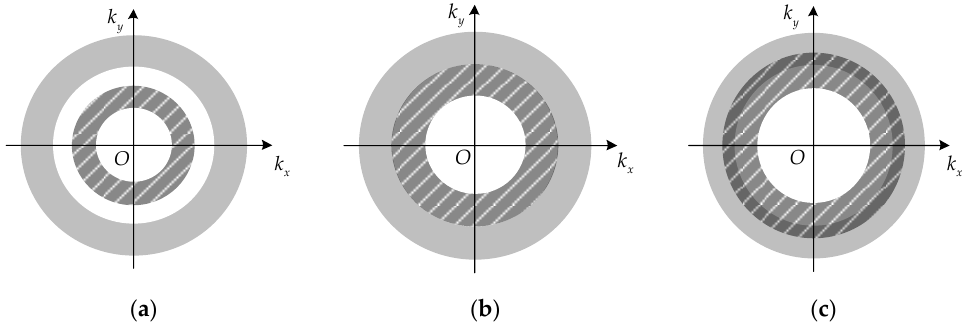
Figure 4. The distribution of two antennas’ spectral supports: ( a ) Separate; ( b ) Adjacent; ( c ) Overlapping.